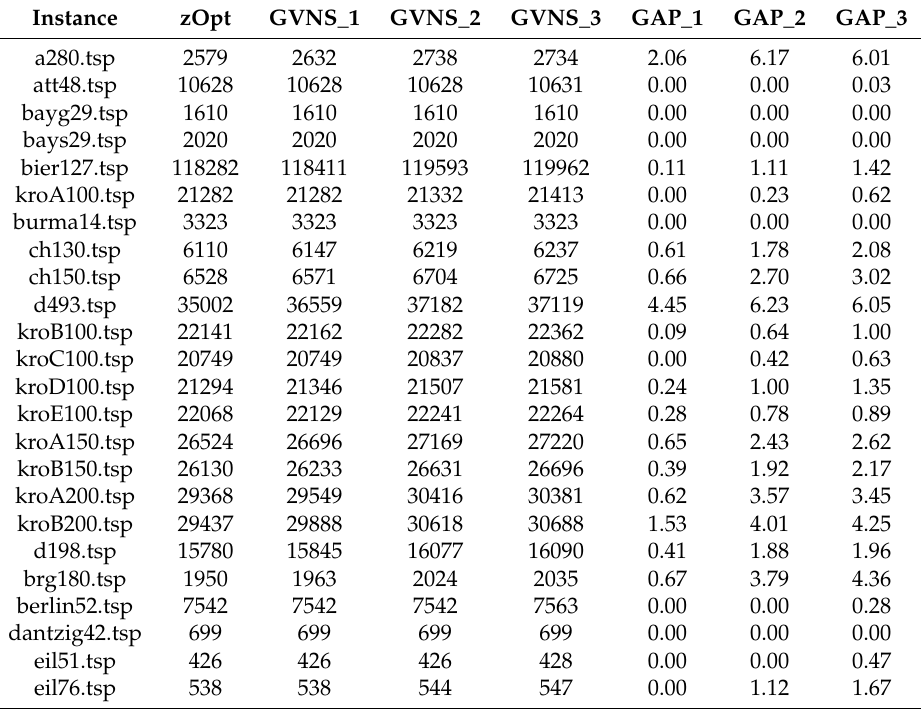
Table 6. Results using the Best Improvement search strategy and an execution time limit of 1